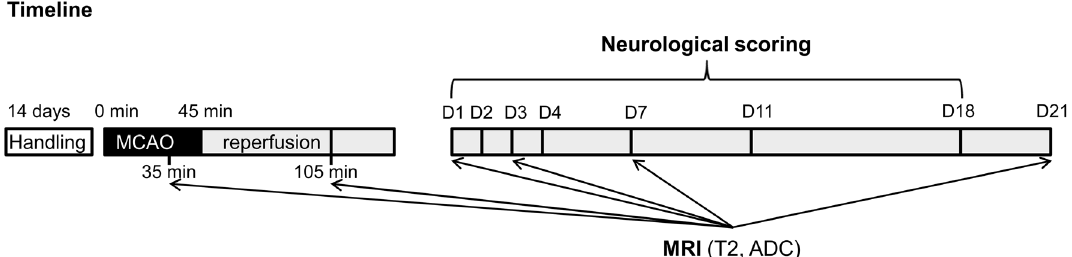
Figure 1. Schematic representation of experimental protocol. MCAO middle cerebral artery occlusion, D1-21 Day 1–21, T2 T2-weighted imaging, ADC apparent diffusion coefficient measurement; black color represents the 45-min period of filament occlusion; gray indicates the 21 day period after